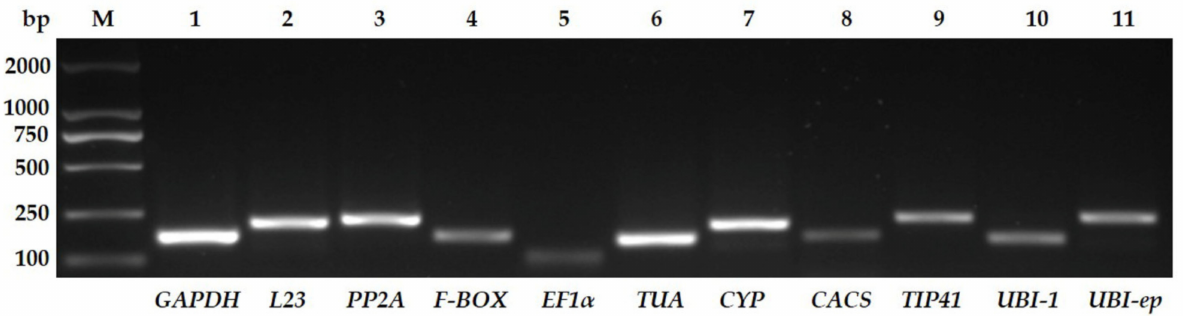
Figure 2. Amplification products of the eleven candidate reference genes. Lane M, Trans2K DNA marker; lane 1, GAPDH ; lane 2, L23 ; lane 3, PP2A ; lane 4, F-BOX ; lane 5, EF1 α ; lane 6, TUA ; lane 7, CYP ; lane 8, CACS ; lane 9, TIP41 ; lane 10, UBI-1 ; lane 11, UBI-ep .